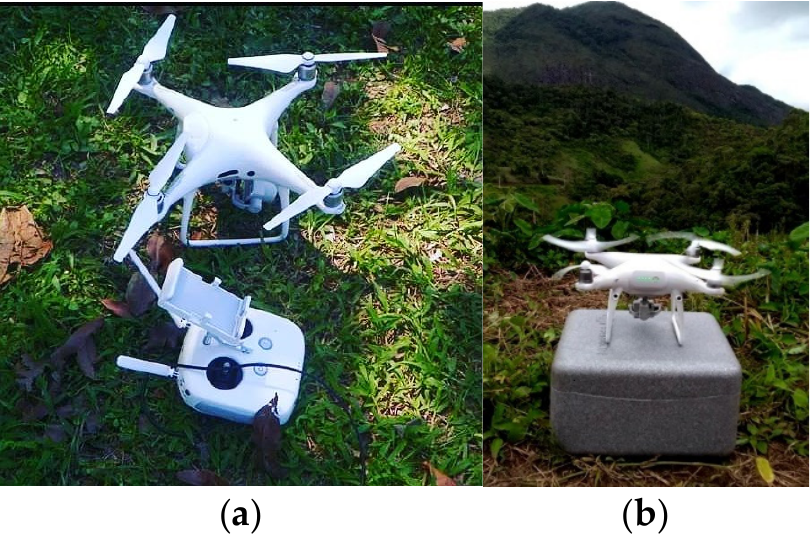
Figure 6. Phantom 4 Pro RPA for field survey. ( a ) Above view, and ( b ) Side view.